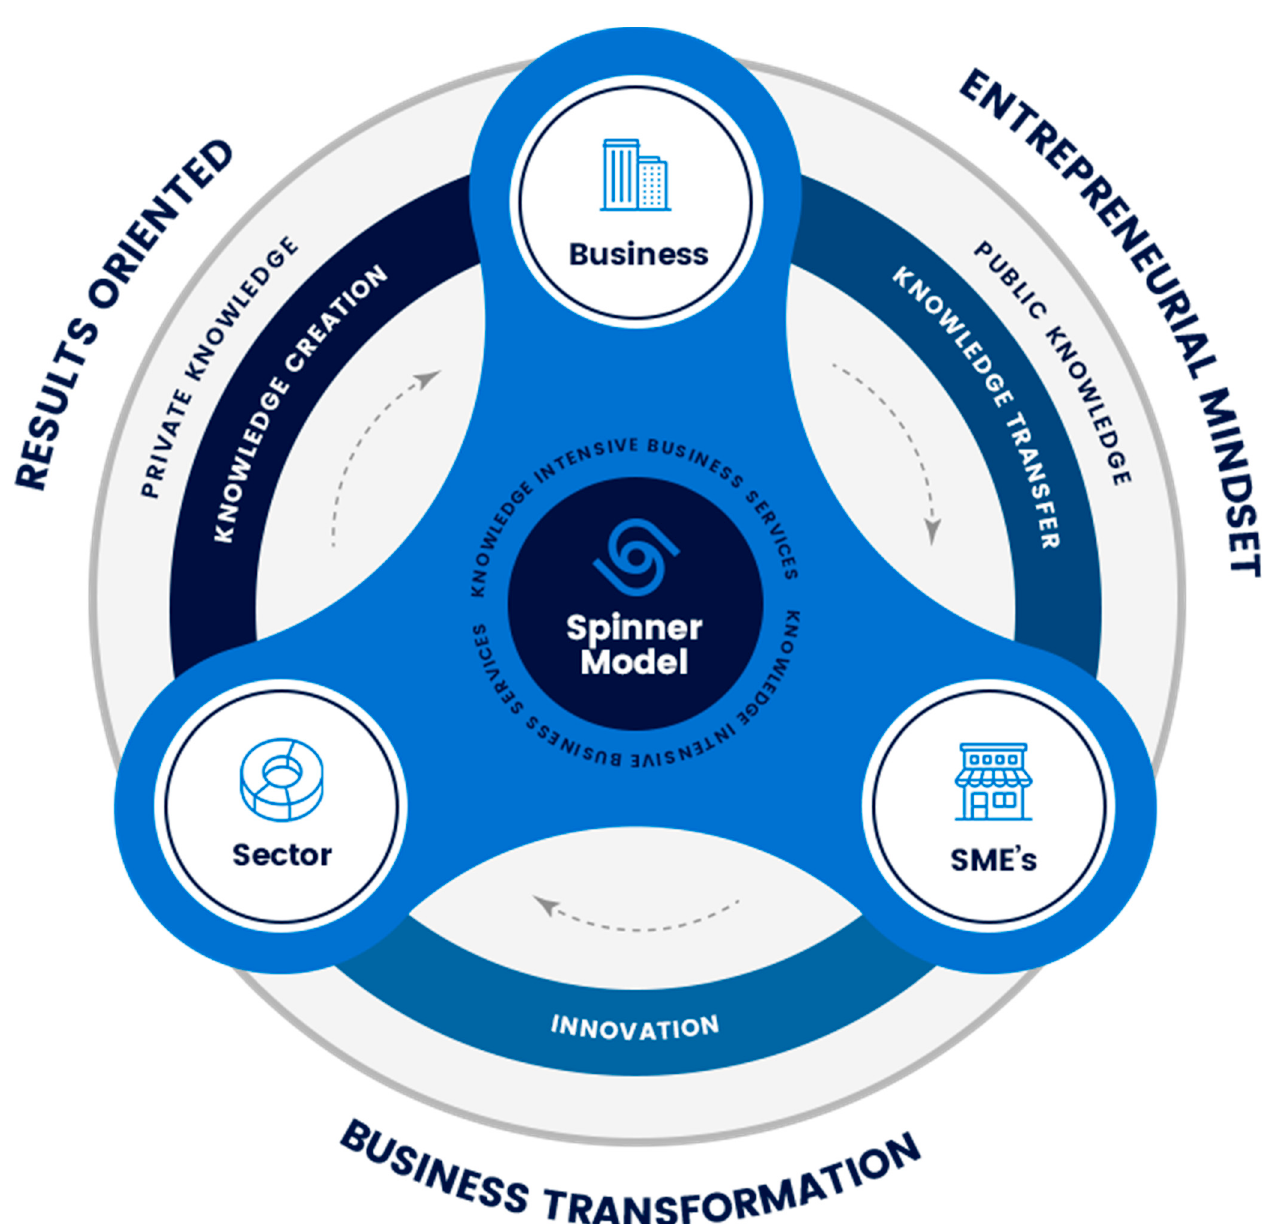
Figure 1. Spinner Innovation Model .